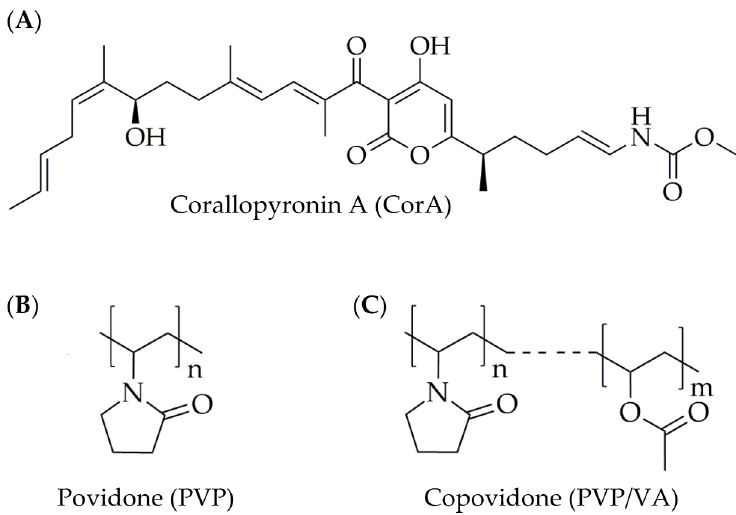
Figure 1. Chemical structures of the natural antibiotic corallopyronin A (CorA) ( A ), and the polymers povidone (PVP) ( B ) and copovidone (PVP/VA) ( C ).